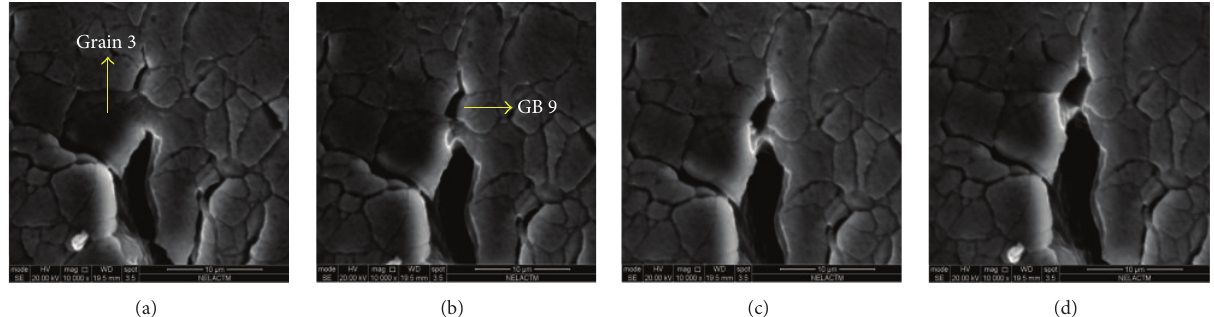
Figure 10: Micromorphology of fatigue crack at different loading cycles: (a) at 126 cycles, (b) at 129 cycles, (c) at 130 cycles, and (d) at 131 cycles.